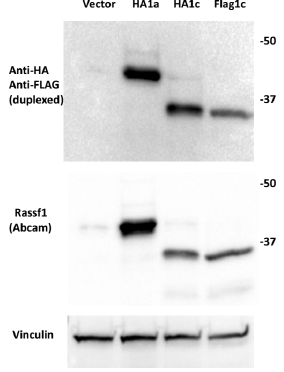
Figure A4. Western blotting verification of RASSF1 antibody and overexpressed isoforms. H1299 cells were transfected with HA-tagged RASSF1A (Addgene#1980), HA-tagged RASSF1C (Addgene#1981), FLAG-tagged RASSF1C (Addgene#1977) or empty vector and harvested 2 days post-transfection. HA or FLAG tags were probed by Anti-HA: Anti Flag mixed antibodies. RASSF1A and C were probed by RASSF1 antibody (EPR7127, Abcam). Vinculin was probed as loading